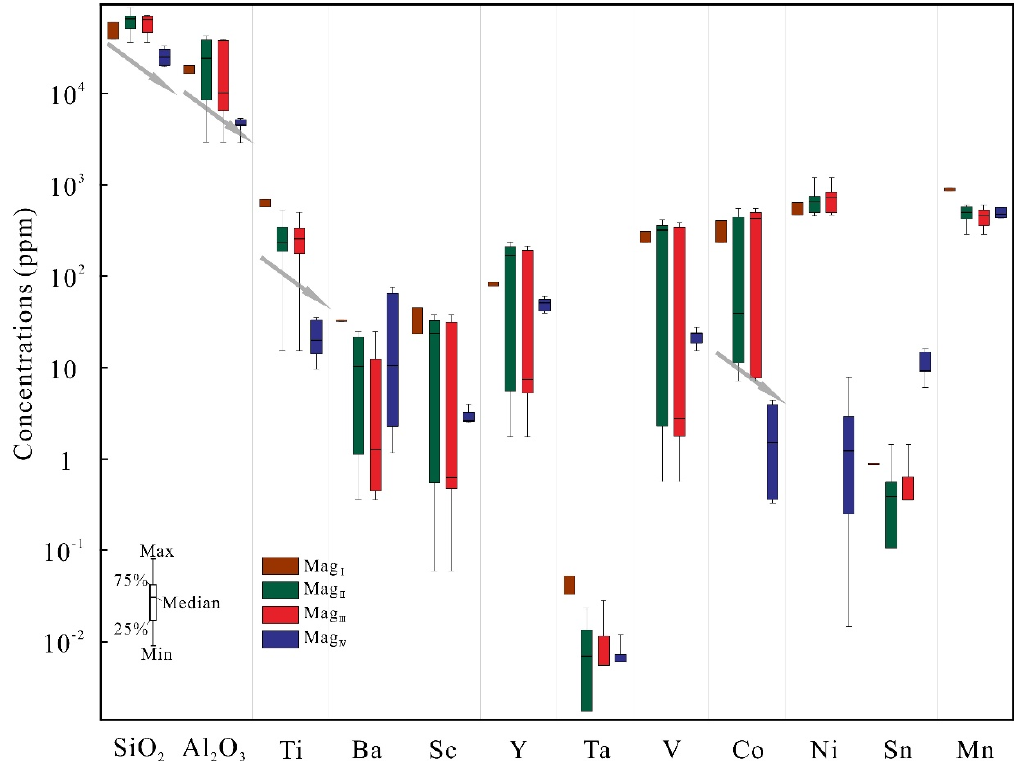
Figure 8. Comparative box plot of SiO 2 , Al 2 O 3 , Ti, Ba, Sc, Y, Ta, V, Co, Ni, Sn, and Mn concentrations of the different magnetite generations.